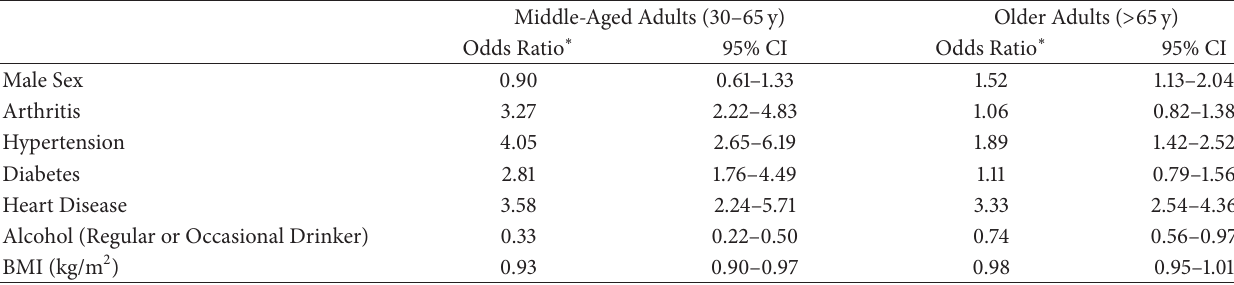
Table 3: Odds of stroke in middle-aged and older